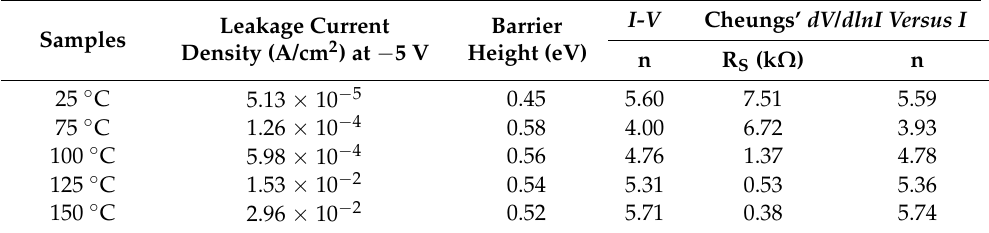
Table 5. The Parameters and the Electrical Characteristics of the p-Sb 0.14 GaN/n-Si Diode Tested at Different